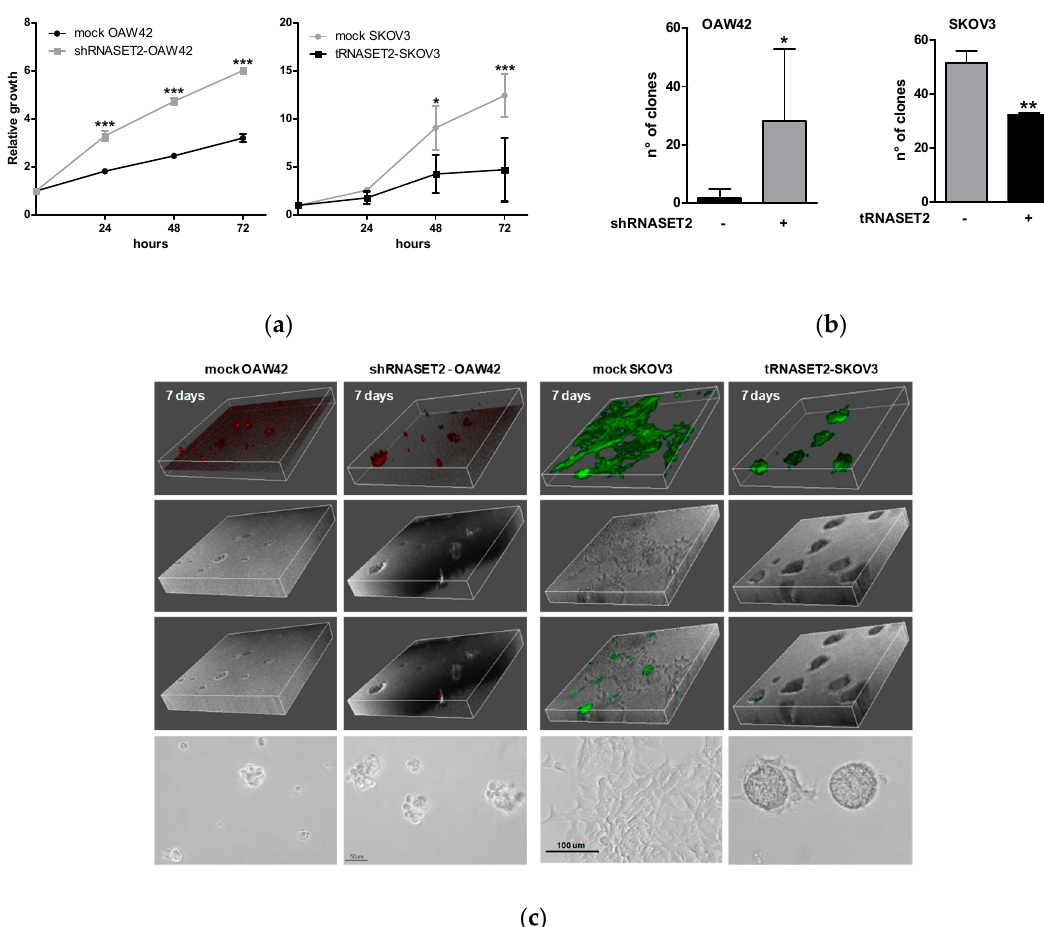
Figure 3. RNASET2 expression negatively impinges EOC cell growth. ( a ) Left panel: proliferation assay performed on mock and shRNASET2-OAW42 cells. Cell viability was measured by CellTiter-Glo ® Luminescent Cell viability assay (Promega). Results are presented as relative growth to T0. Asterisks indicate significant values (*** p < 0.001). Right panel: proliferation assay performed on mock and tRNASET2-SKOV3 cells. Number of cells was determined by a manual count. Results are presented as relative growth to T0. Asterisk indicates significant values (* p < 0.05 and *** p < 0.001). Error bars, SD. ( b ) Clonogenic assay of mock/shRNASET2-OAW42 (left panel) and mock/tRNASET2-SKOV3 cells (right panel) grown in soft agar for 20 days. The graphs report the number of clones/well. Asterisk indicates significant values (* p < 0.05 and ** p < 0.01). Error bars, SD. ( c ) Three-dimensional deconvolution of confocal images of cells growing and invading Matrigel ® (Corning, New York, NY, USA) at 7 days. From top to bottom: fluorescent images, dichroic images, merge of both and phase contrast images of the same cells. Left panel: mock and shRNASET2-OAW42 cells labeled with PKH26 Red Fluorescent Cell Linker Kits (Sigma-Aldrich) as described in Materials and Methods section. Right panel: mock and tRNASET2-SKOV3 cells stably transfected with a pcDNA3-based expression vector encoding GFP alone or RNASET2 and GFP, respectively.